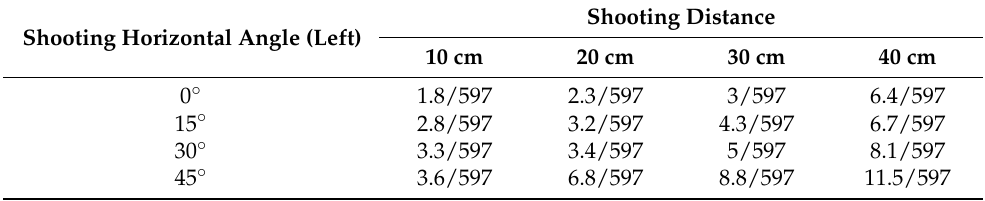
Table 4. Average BER under different shooting conditions in watermark B